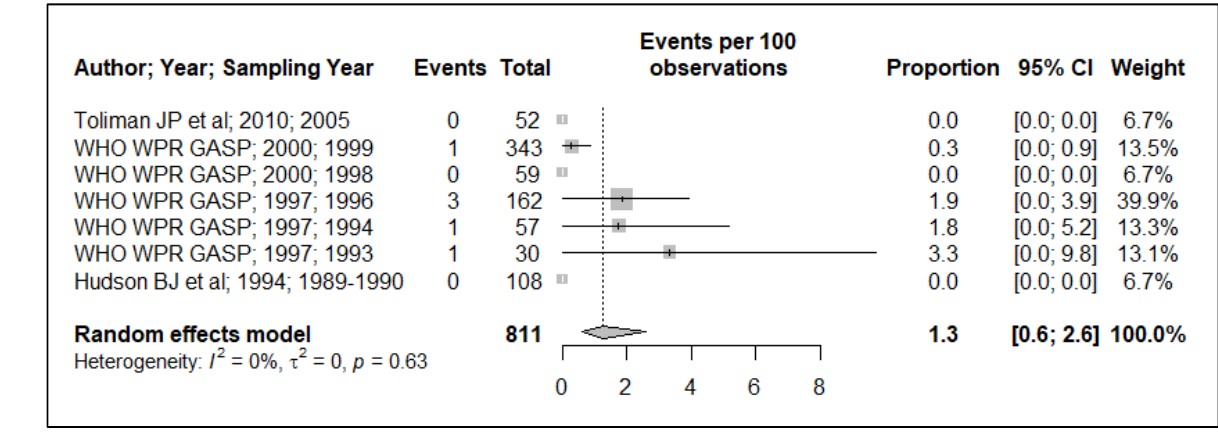
Figure 5. Quinolone (ciprofloxacin) resistance prevalence estimate.